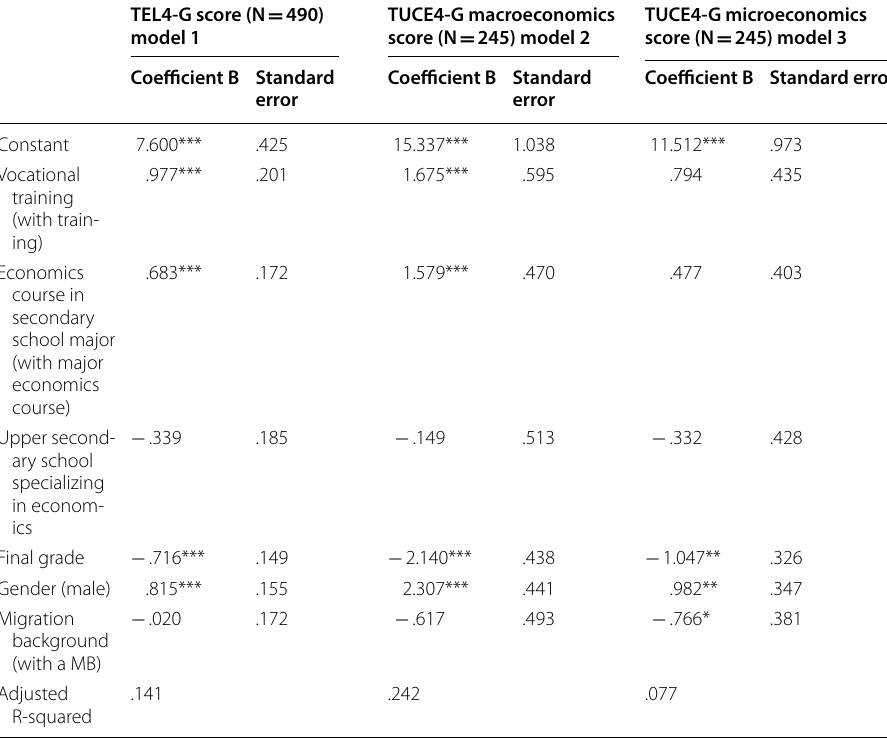
Table 4 Multiple linear regression models based on economic